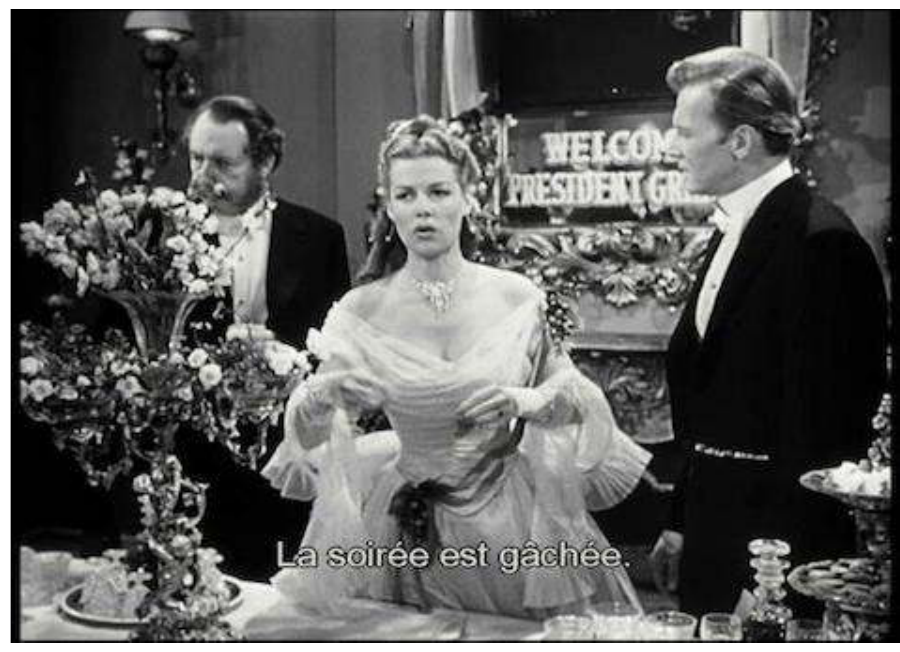
Raoul Walsh, between the Western and the Southern: Pursued (1947), Silver